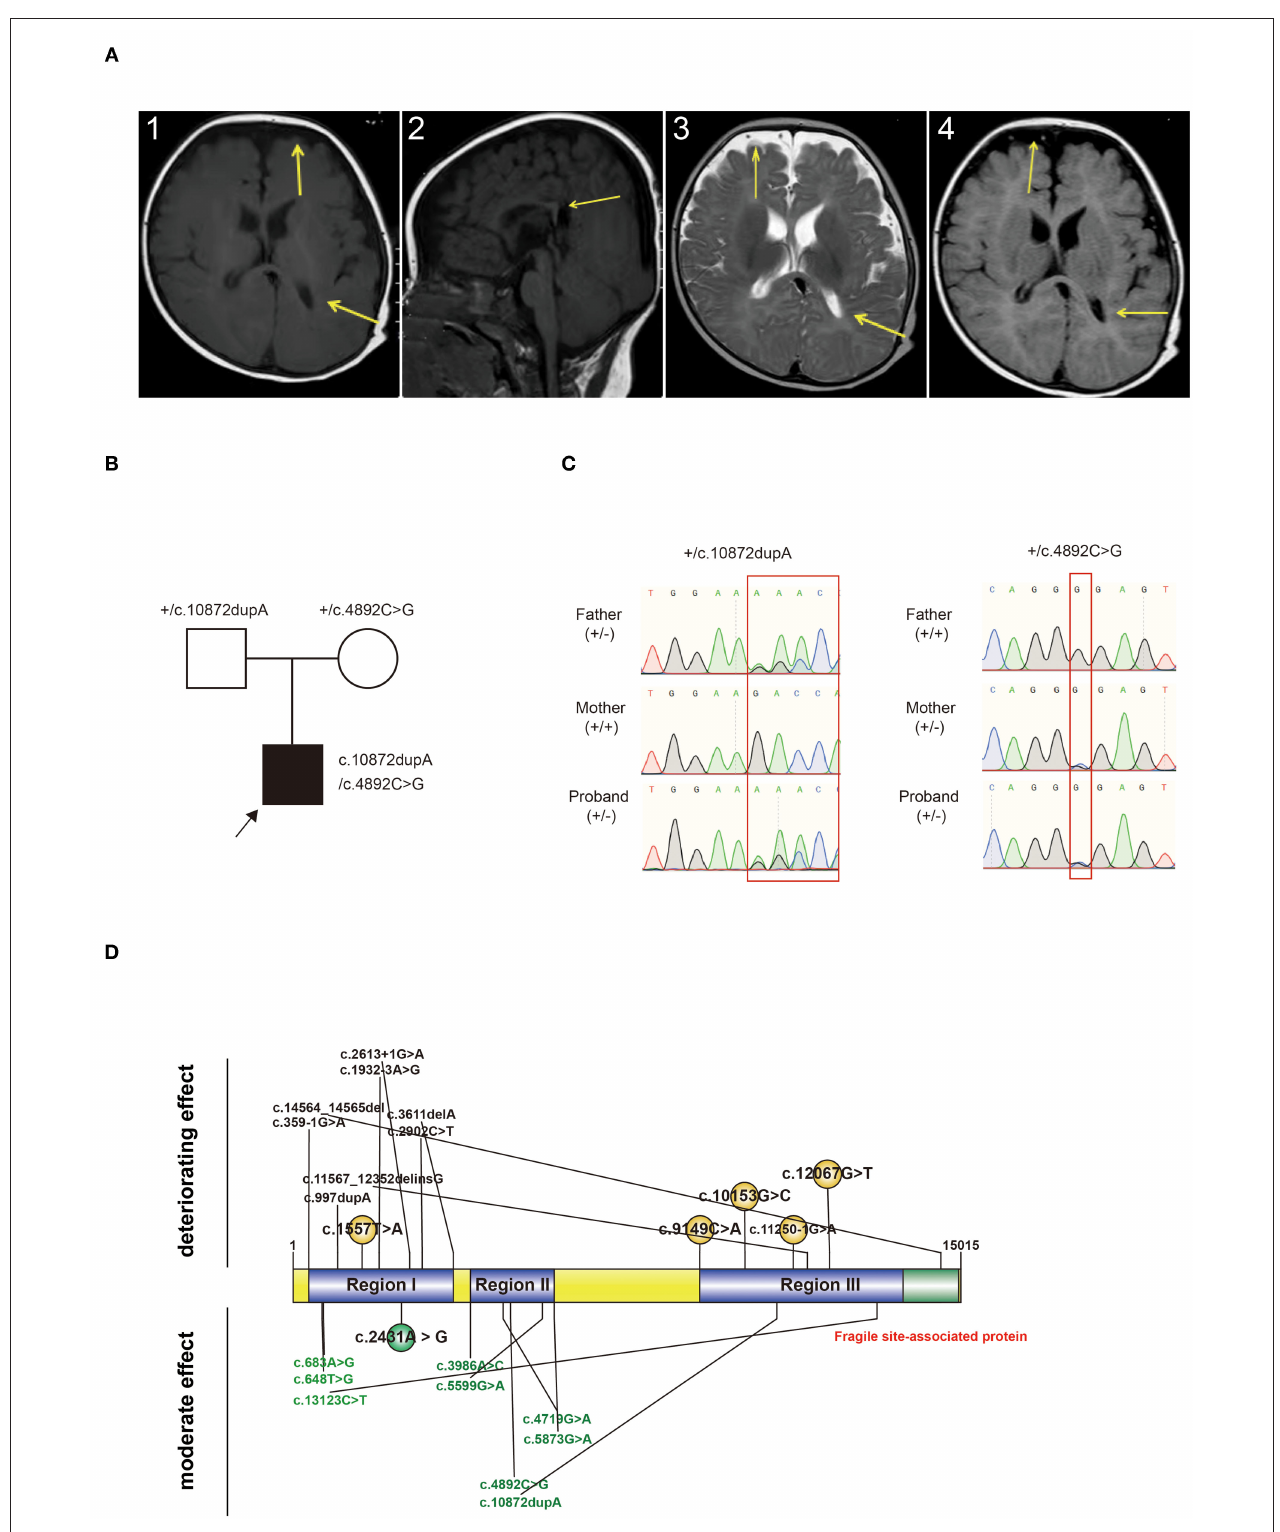
FIGURE 1 | (A) Characteristic changes in the MRI findings of the proband. MRI images revealed a widening of bilateral frontotemporal space, an irregular shape of the left ventricle, and a short corpus callosum. A.1 and A.2: T1W; A.3: T2W; A.4: FLAIR. Arrow: Change of sites. MRI: magnetic resonance imaging. (B) Pedigree chart and genotype information of the proband. Black arrow: proband. + : wildtype. (C) Genotype validated by Sanger sequencing. Compound heterozygous variants were